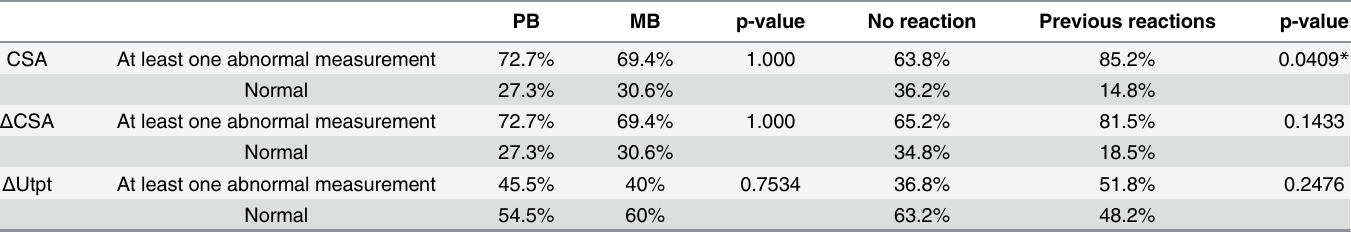
Values were considered abnormal when they exceeded the mean + 2SD value obtained from healthy volunteers. p-value by two-tailed Fisher ’ s